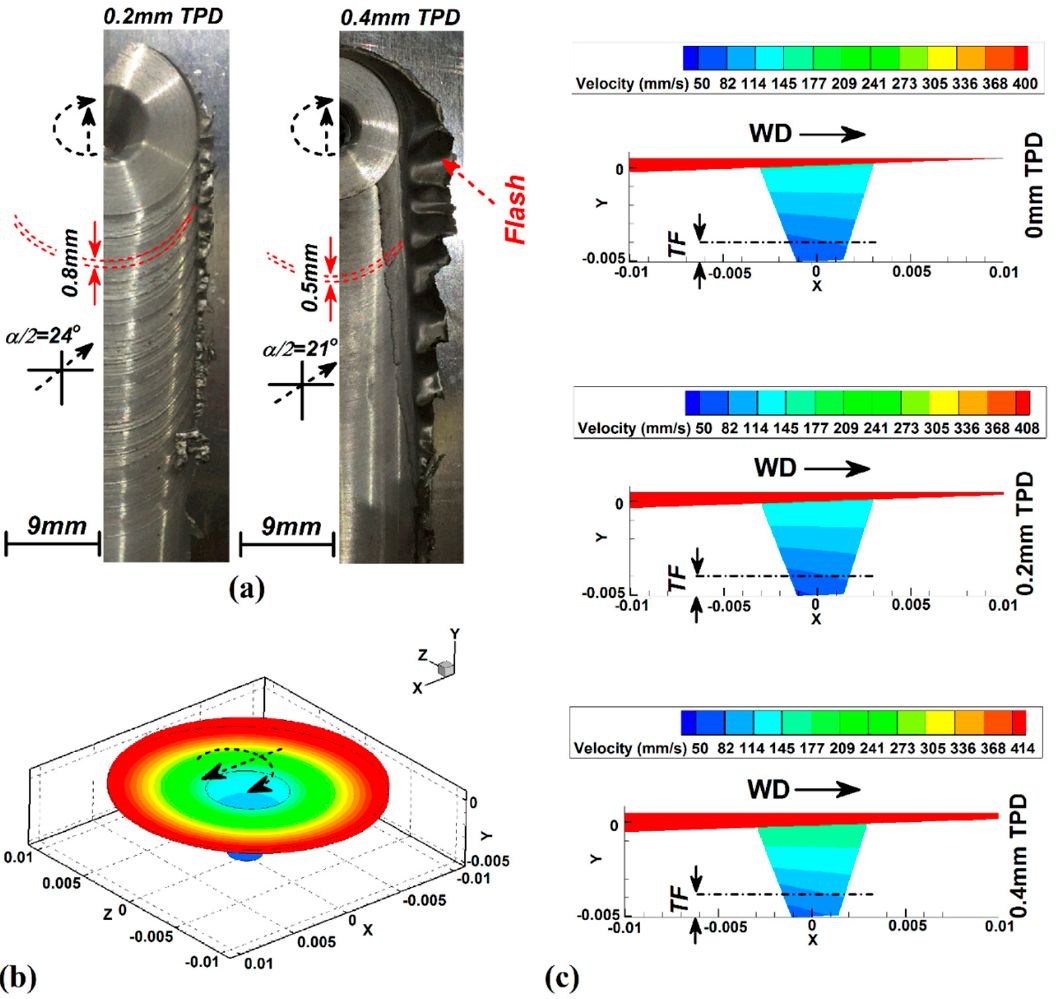
Figure 6. ( a ) Surface materials flow at 0.2 mm and 0.4 mm TPD. ( b ) Three-dimensional (3D) view of material velocity from simulation result. ( c ) Side view from velocity simulation result of various TPD.